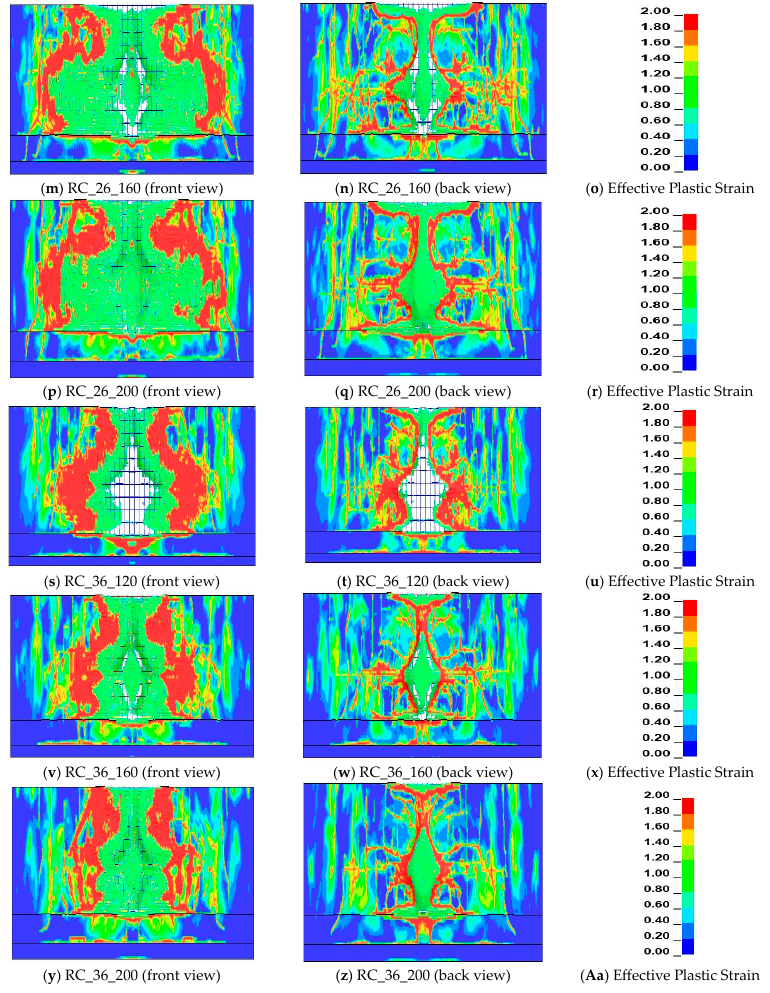
Figure 10. E ff ective plastic strain on reinforced concrete with di ff erent thickness and stand-o ff dis- tance during Worse Case Scenario. Figure 10. Effective plastic strain on reinforced concrete with different thickness and stand-off distance during Worse Case